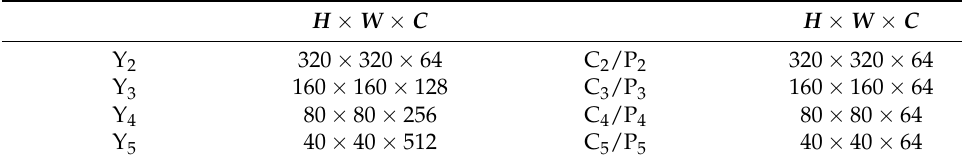
Table 1. Size of feature